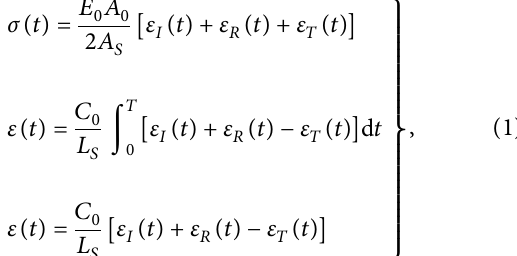
Figure 4: Curves of pH value variation with time in hydrochemical solutions.